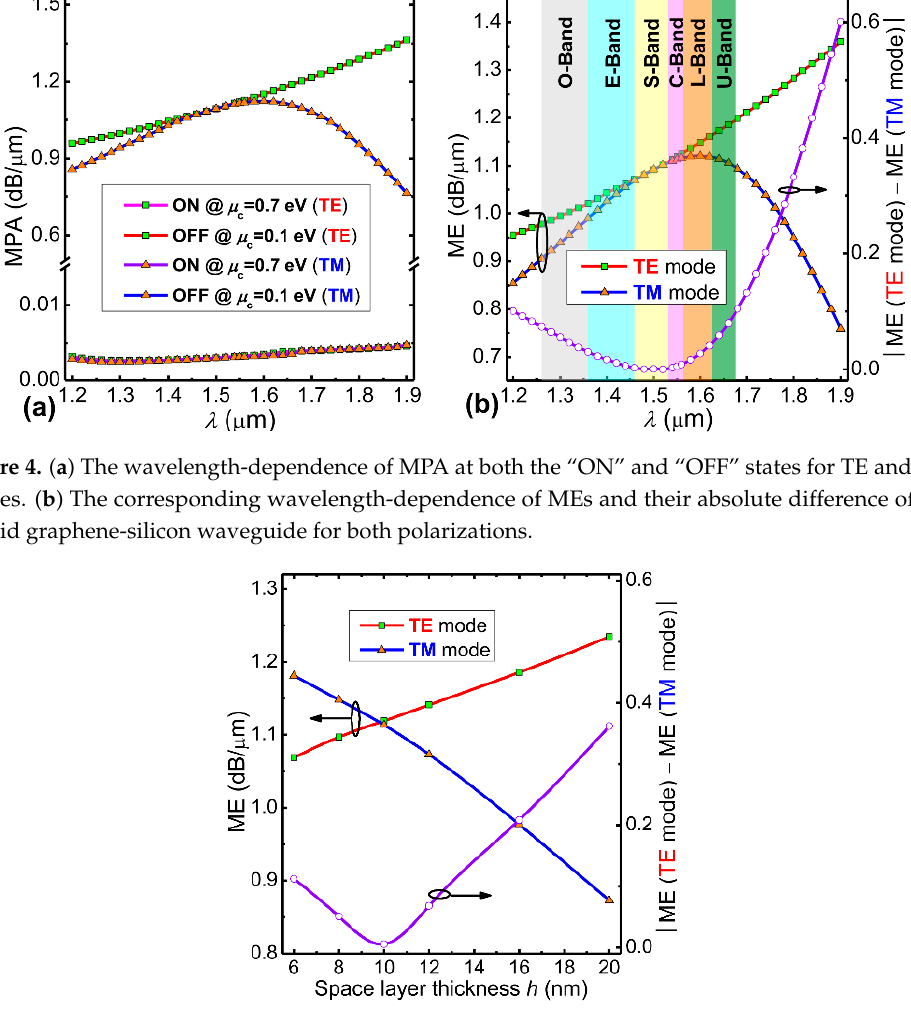
Figure 5. The calculated MEs and their absolute difference of the hybrid graphene-silicon waveguide for both polarizations versus the spacer layer thickness h .